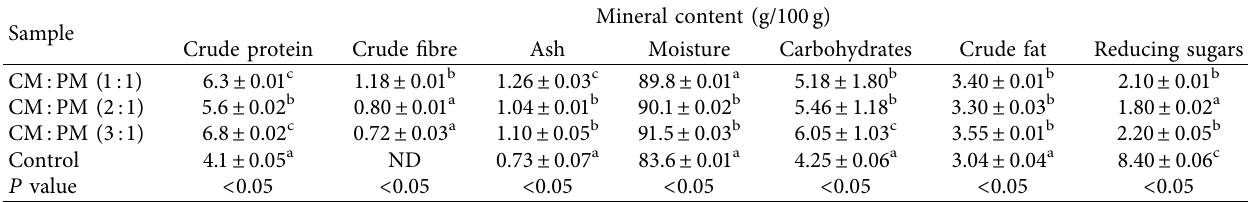
Table 1: Proximate composition of fermented cowpea-peanut milk with L. rhamnosus Yoba.